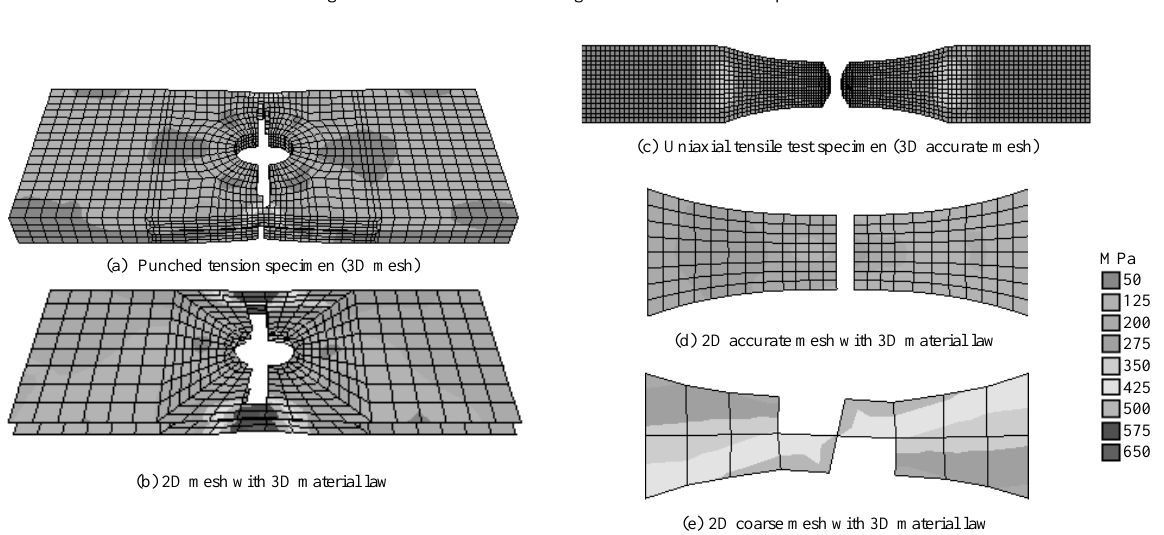
Fig. 16. Load vs. local strain diagram – Uniaxial tensile specimen.